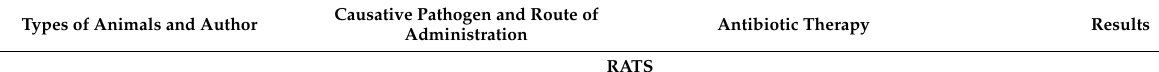
Table 2. Preclinical assessment of antibiotics in animal models of acute otitis